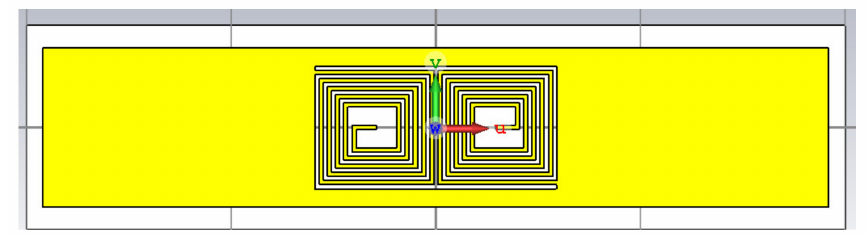
Figure 14. Planar coupling between two side-by-side spiral inductors.